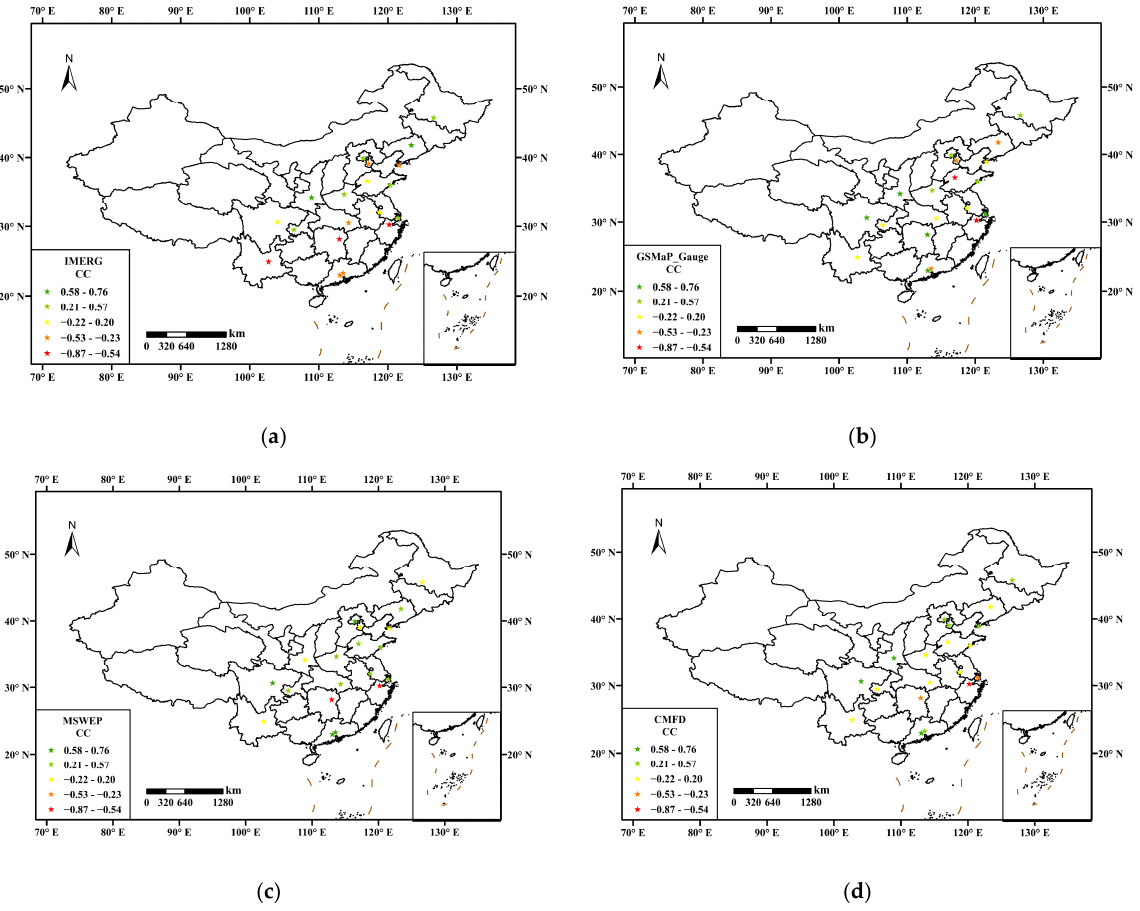
Figure 9. The correlation coefficient between R99TOT values of SPPs data and rain gauges in 21 major cities: ( a ) IMERG, ( b ) GSMaP_Gauge, ( c ) MSWEP, and ( d ) CMFD. Figure 10 shows the RB of the R99TOT values between SPPs data and urban gauges observations in 21 major cities. The spatial distribution of the RB from four SPPs shows a substantial disparity. Overall, GSMaP_Gauge shows the best performance among the four SPPs, but it still exhibits high RB of R99TOT in some cities, such as Beijing and Jinan. IMERG and CMFD show high spatial variability and exhibit high RB in several cities. Specifically, in IMERG, RB is higher than 50% in Shanghai and Harbin, and in CMFD, it exceeds 50% in Shenzhen, indicating a high risk of error in these areas. In contrast, MSWEP exhibits a consistently underestimation of R99TOT, similar to these of R99. ( a )